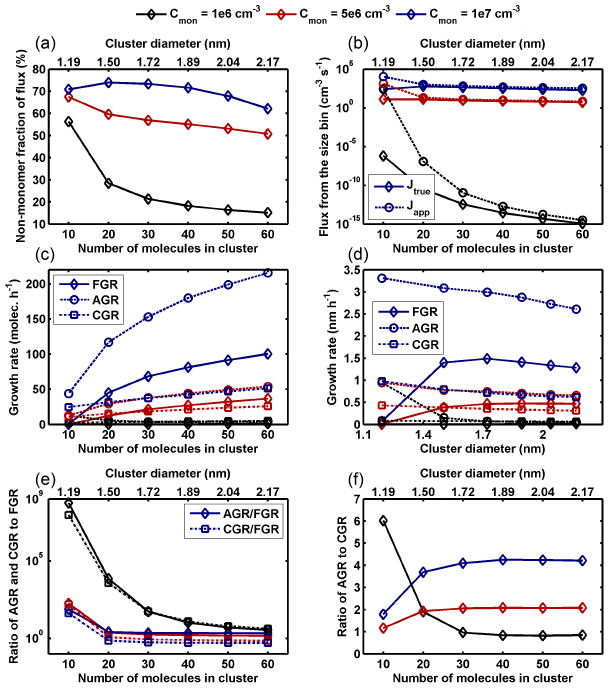
Figure 4. The effect of steady-state monomer concentration (shown as different colors) on quantities describing cluster growth in the presence of stable small clusters: (a) the non-monomer fraction of flux from each size bin; (b) the true collision–evaporation flux from each size bin ( J true ; solid line) and the fluxes calculated from the appearance times of clusters ( J app ; dashed line); (c, d) the flux- equivalent growth rate (FGR; solid line), the growth rate derived from the appearance times of clusters (AGR; dashed line), and the growth rate calculated based on irreversible vapor condensation (CGR; dotted line); (e) the ratios of AGR to FGR (solid line) and CGR to FGR (dotted line); (f) the ratio of AGR to